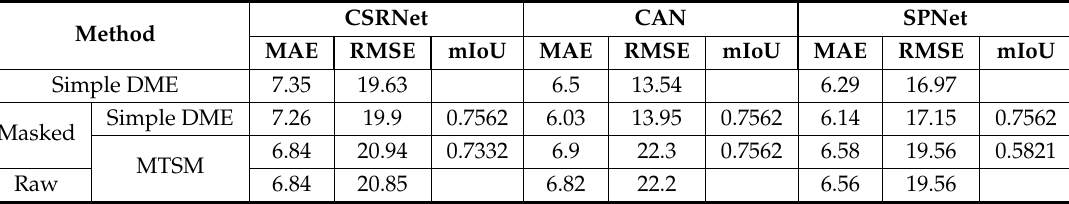
Table 1. Summary of crowd density estimation accuracies for models trained on TH2020. The mean intersection-over-union (mIoU) column is only included to indicate the accuracy of the segmentation mask